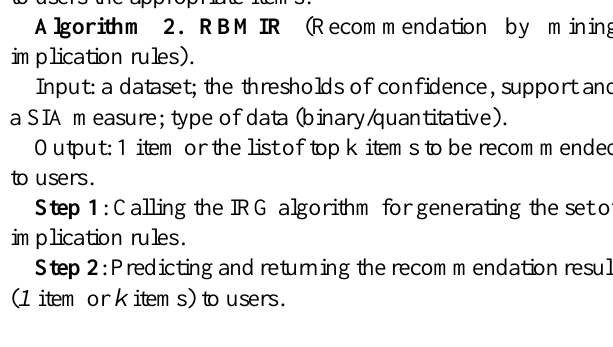
Algorithm 2. RBMIR (Recommendation by mining implication rules).